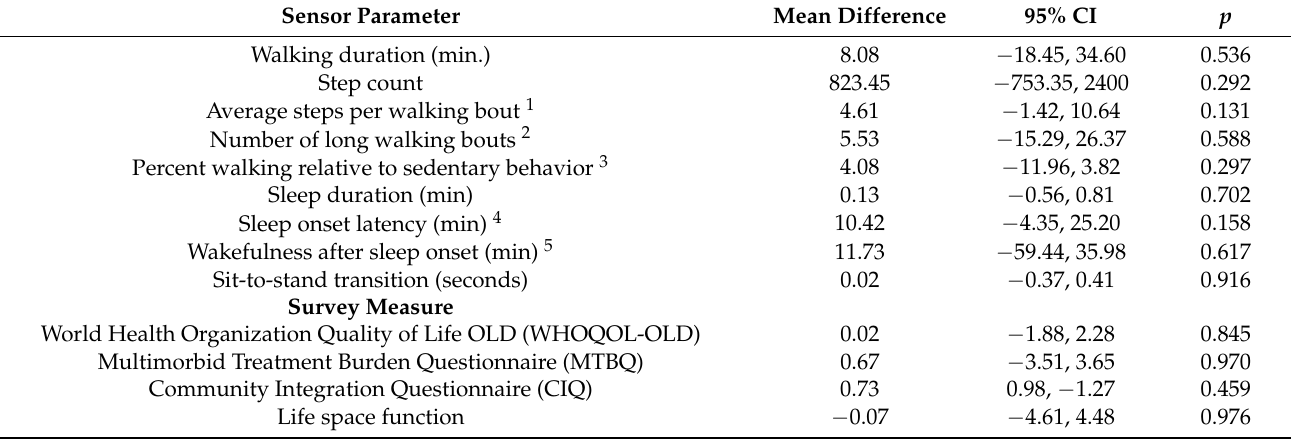
Table 2. Mean differences in physical activity and survey measures at baseline and follow-up.